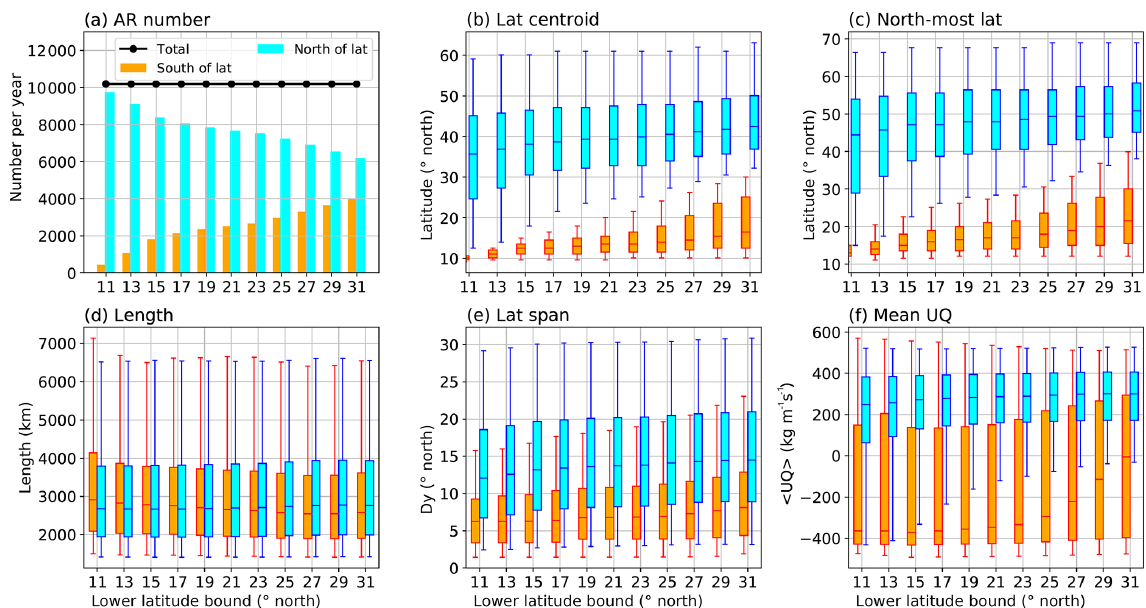
Figure A6. Sensitivity tests on the lower latitudinal bound set to an AR’s centroid. (a) Average annual AR numbers in the Northern Hemi- sphere during 2004 to 2008 when different lower latitude bounds are applied. Cyan (orange) bars show the number of ARs whose centroids are north (south) of the given lower latitude bound. The dotted black line is the sum of the two. (b) Distribution of the AR latitudinal cen- troids for ARs north (in blue) or south (in orange) of the given lower latitude bound. (c) Similar to panel (b) but for the distribution of the north-most axis point in ARs. (d) Similar to panel (b) but for the AR lengths. (e) Similar to panel (b) but for the latitudinal span of the ARs. (f) Similar to panel (b) but for the average zonal component of vertically integrated moisture flux ( < UQ > , in kgm − 1 s − 1